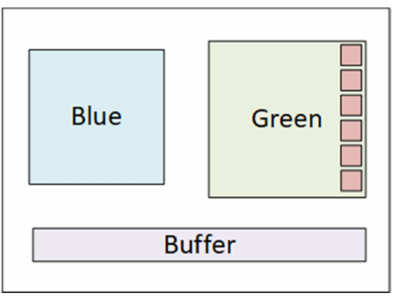
Figure 6. Main elements of a single software node configuration—blue (current version), green with feature flags (updated version), and communication